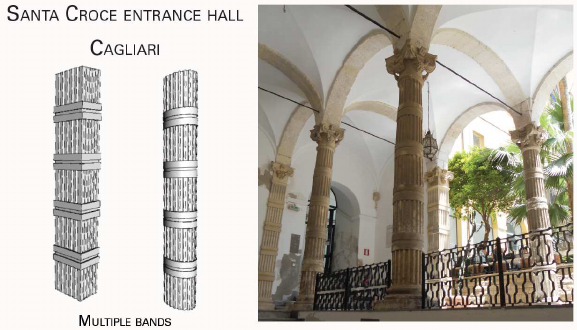
Figure 13. Multi-bands and polygonal drums application in Santa Croce complex